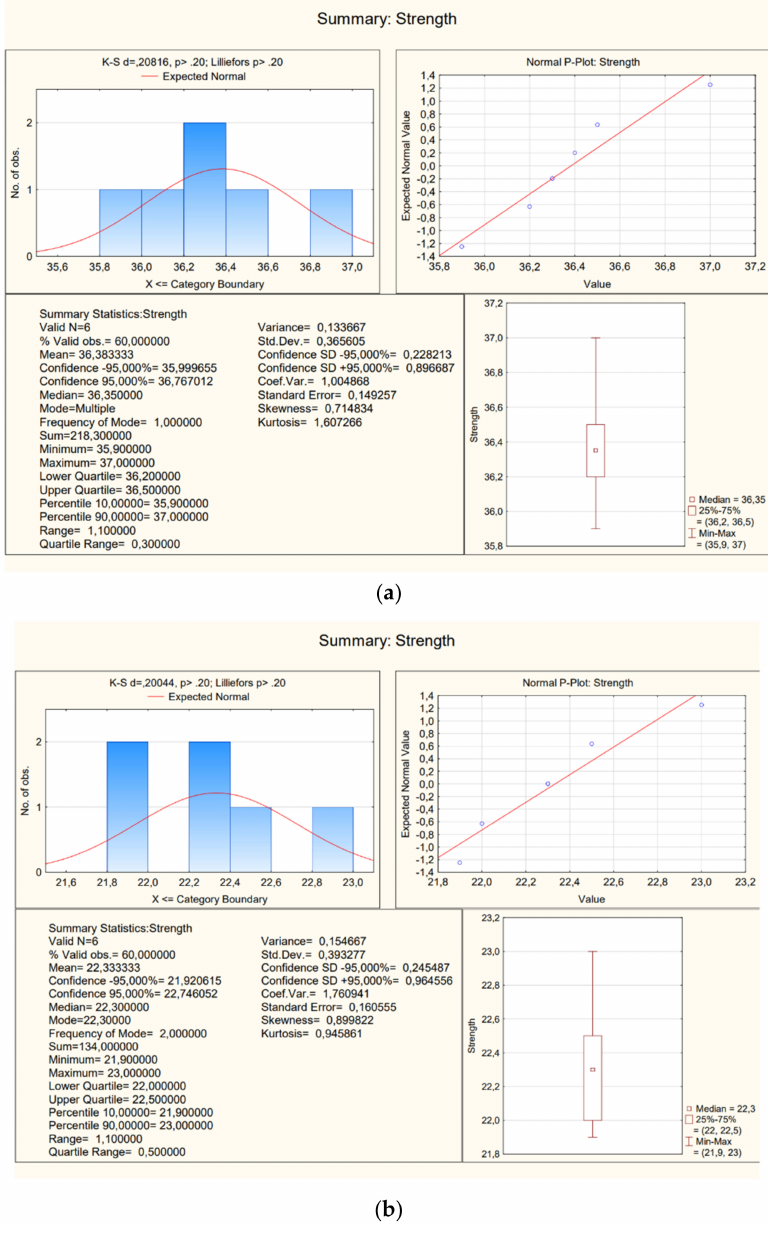
Figure 11. A view of statistics ( a ) samples 5a–f; ( b ) samples